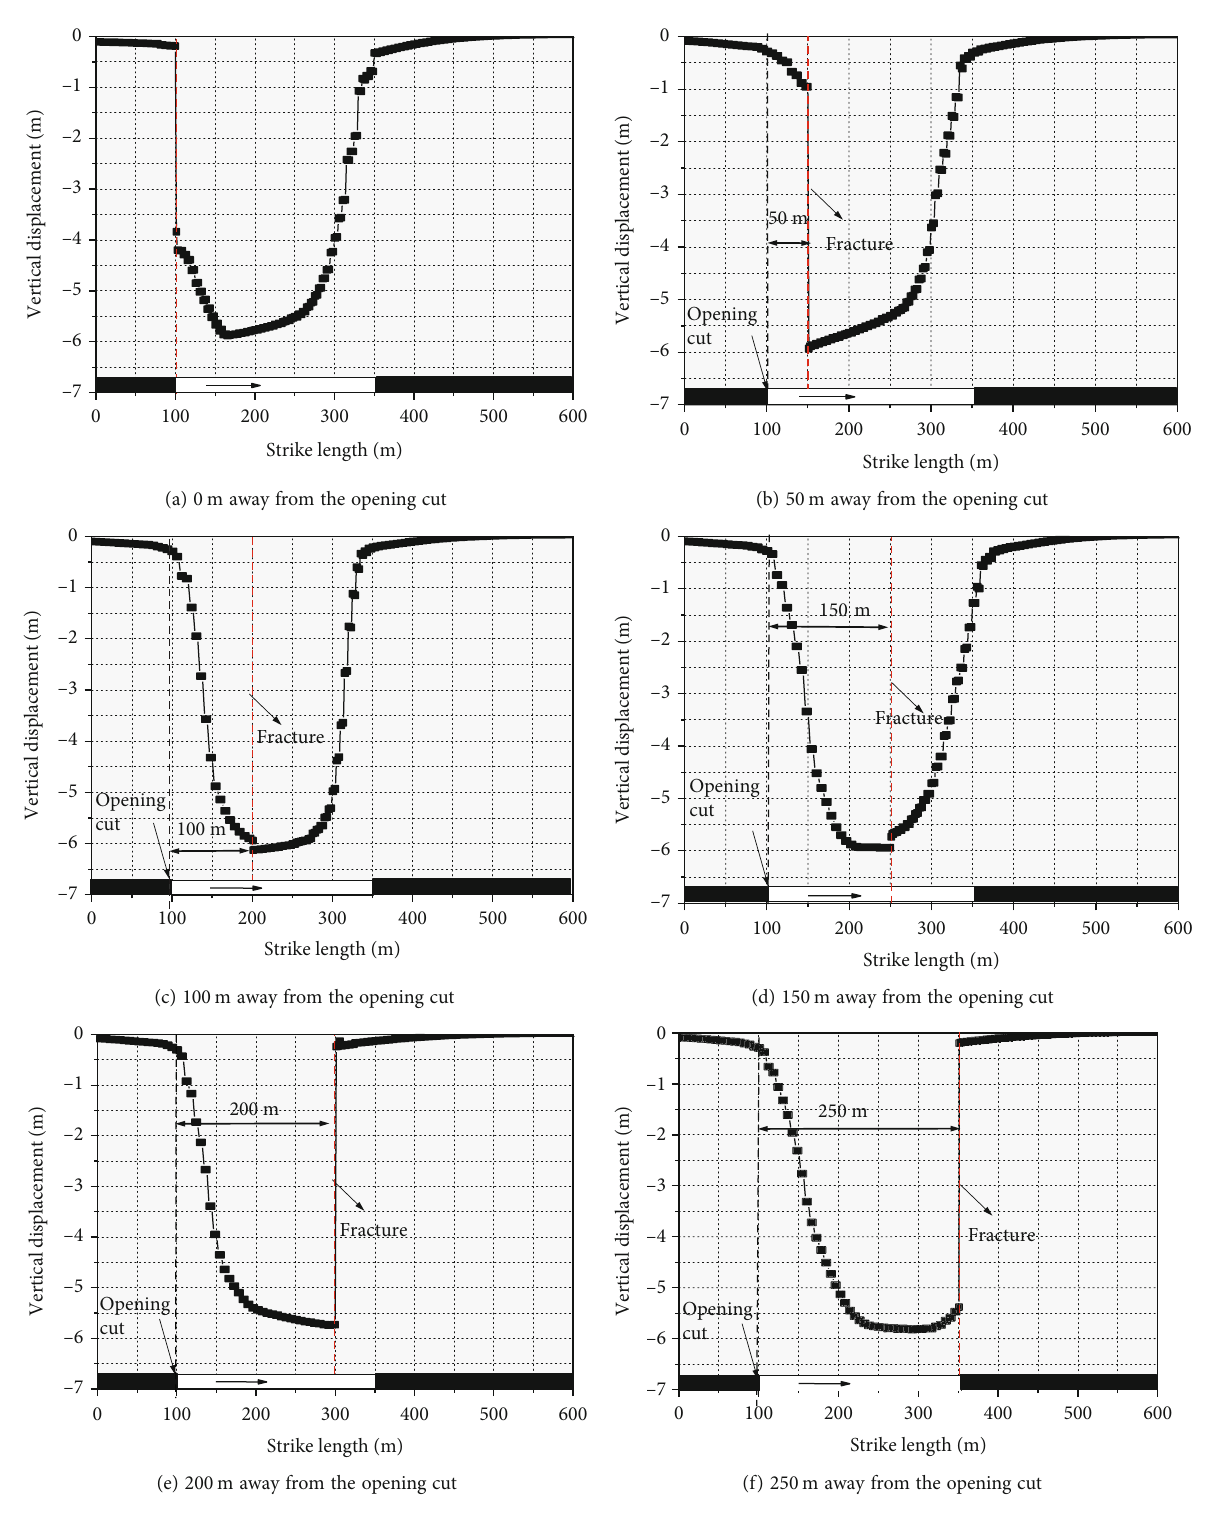
Figure 16: The vertical displacement curve at the THR middle part under di ff erent fracturing